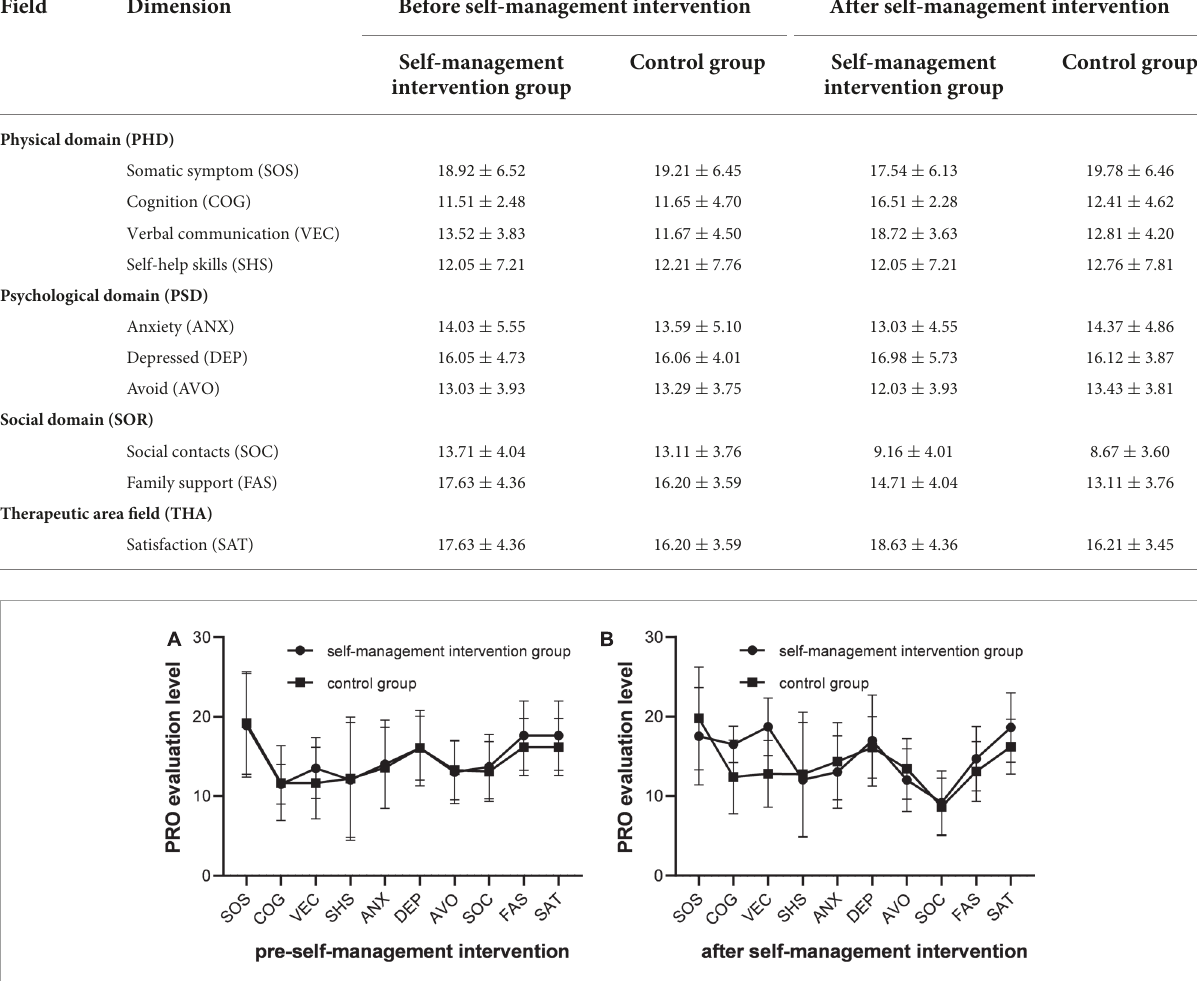
FIGURE1 PRO evaluation results comparison. (A) The PRO scores was no statistical difference among different groups ( P > 0.05), the PRO dimension scores of the two group were not statistically significant (all P > 0.05). (B) The PRO scores was statistical difference among different groups ( P < 0.05), the PRO dimension scores of the two group were not statistically significant (all P >